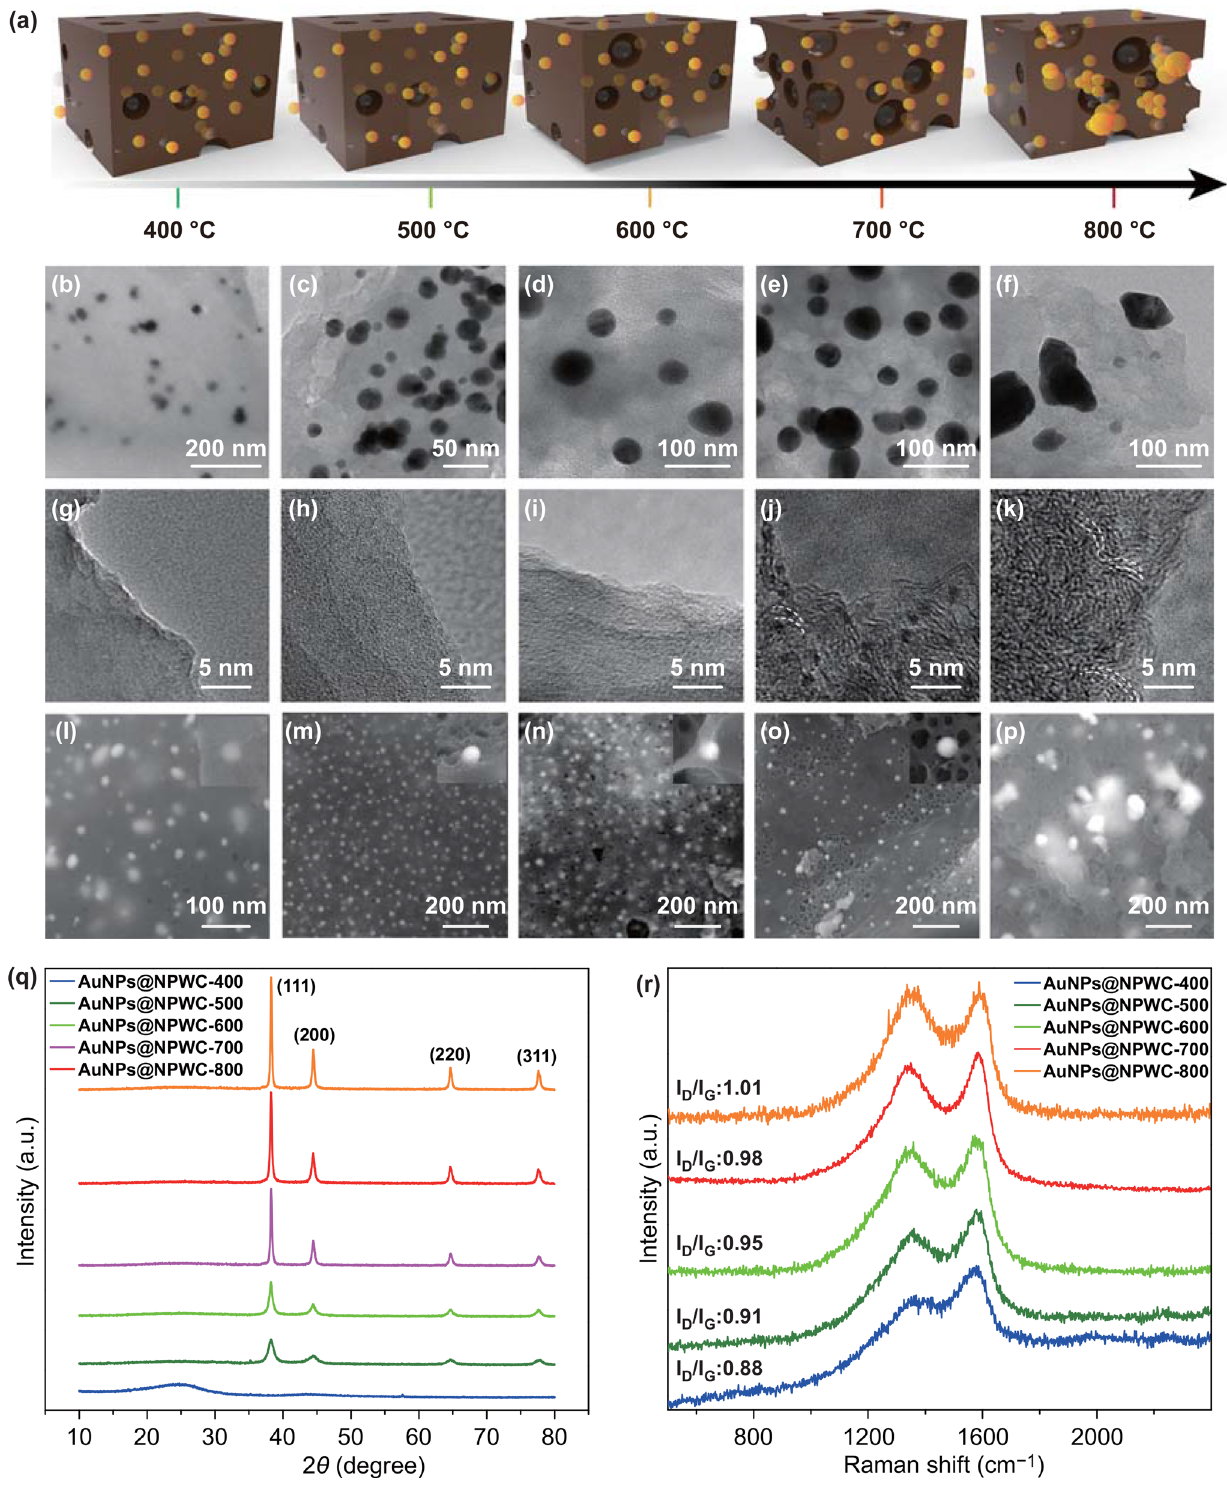
Fig. 3 Effect of carbonization temperature from 400 to 800 °C on carbon skeleton and morphology of the AuNPs. a Schematic illustration. b – f TEM images showing effect of carbonization temperature morphology and dispersion of the AuNPs. g – k Effect on the aromatized carbon skel- eton. l – p SEM images showing effect of carbonization temperature morphology and dispersion of the AuNPs. q Corresponding XRD pattern. r Corresponding Raman